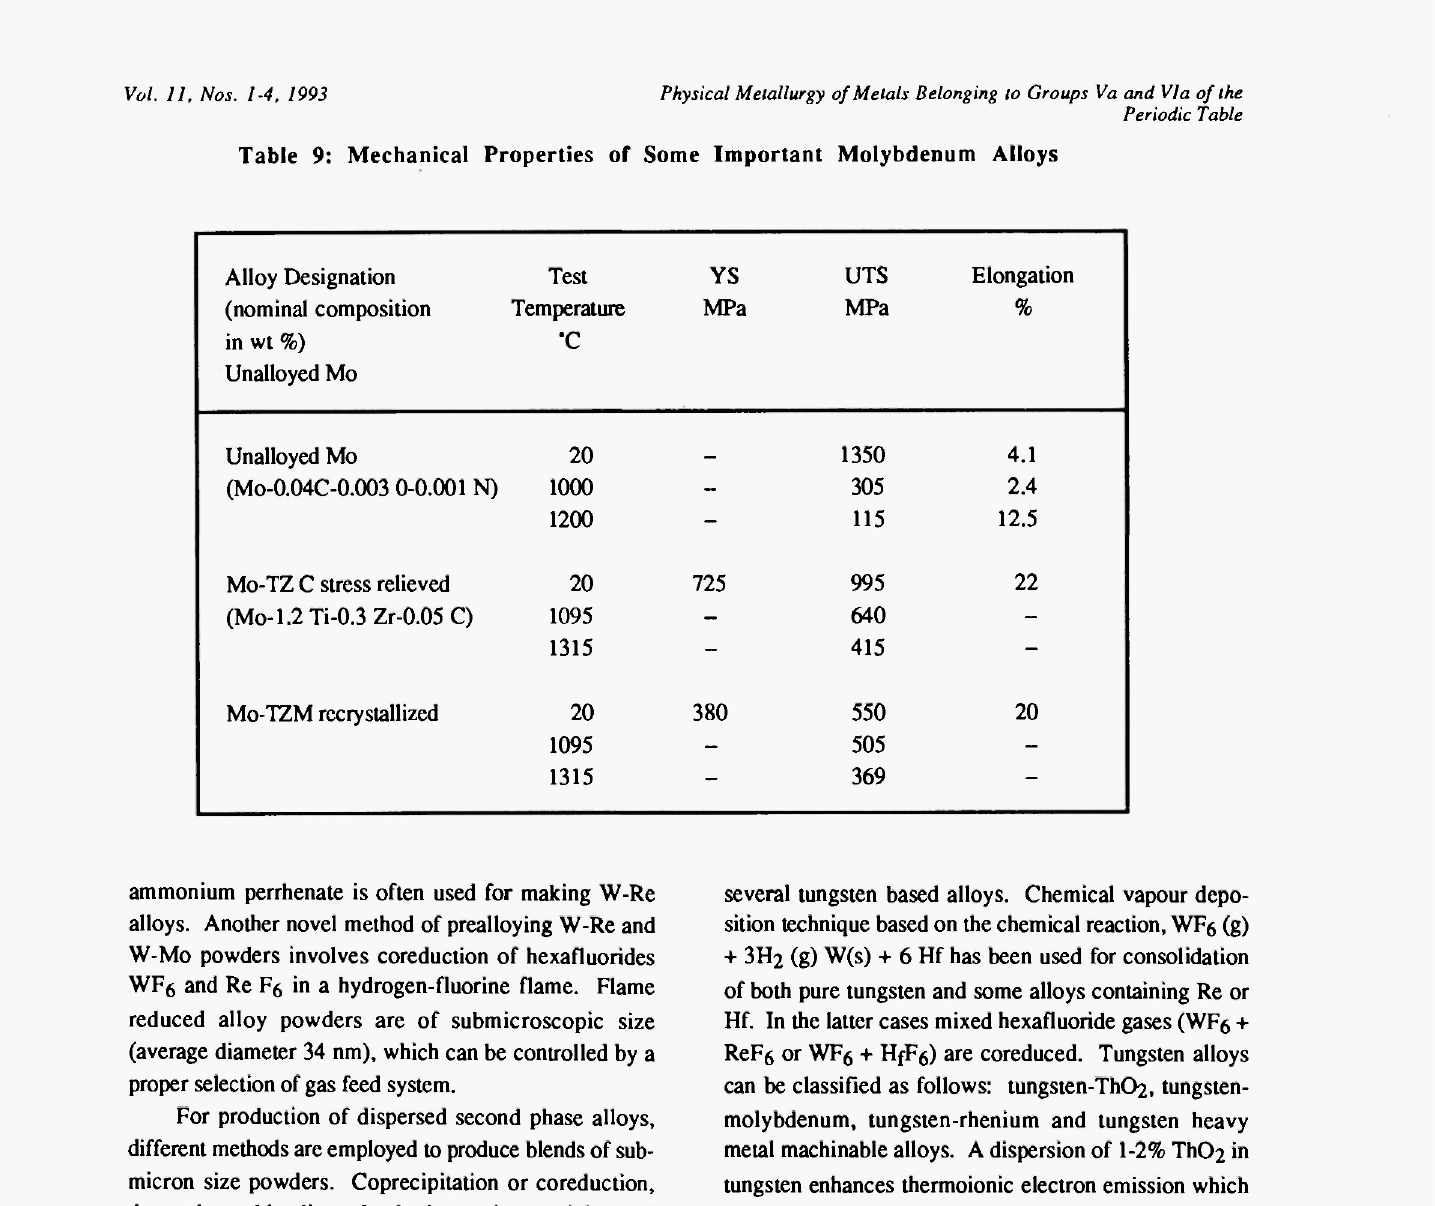
Table 9: Mechanical Properties of Some Important Molybdenum